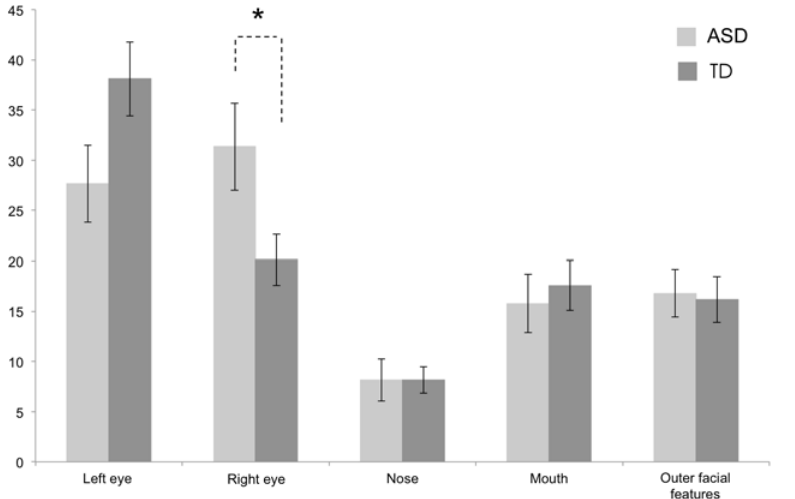
Fig 2. Mean (SE) proportion of fixation time by group for each AOI. * p < .05